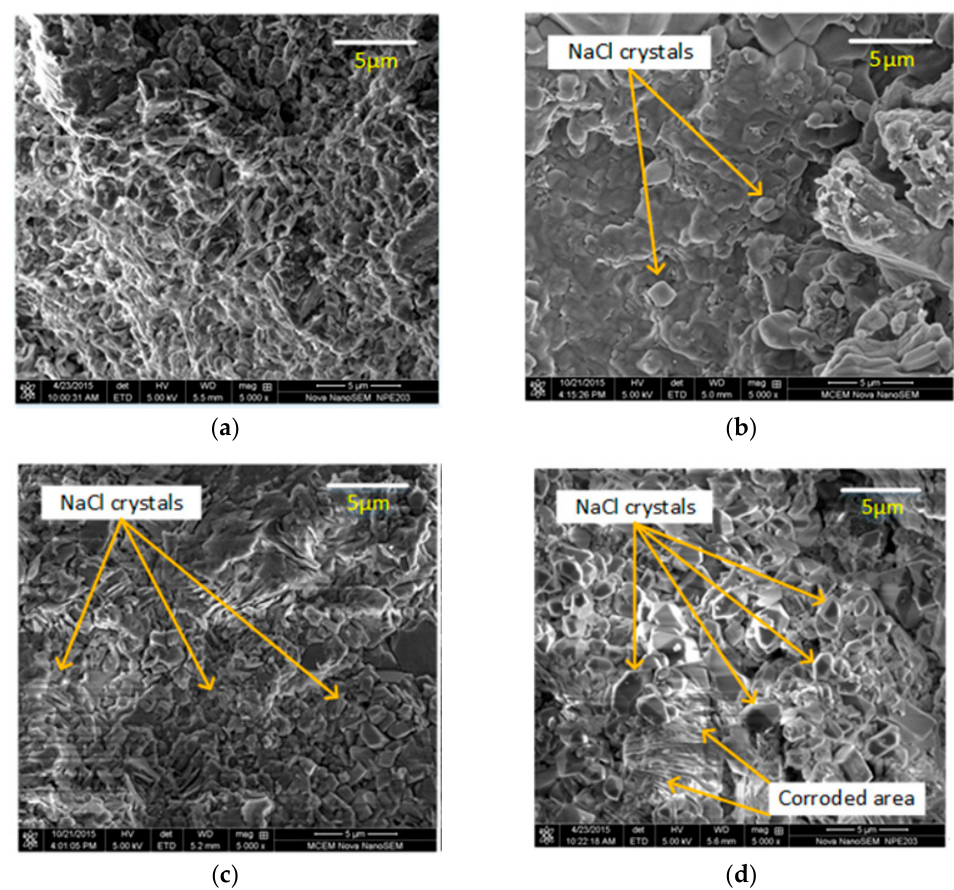
Figure 5. SEM test results of siltstone specimens ( a ) dry; ( b ) 10% NaCl; ( c ) 20% NaCl; ( d ) 25% NaCl. Table 1. Mechanical properties of dry and brine-saturated siltstone.